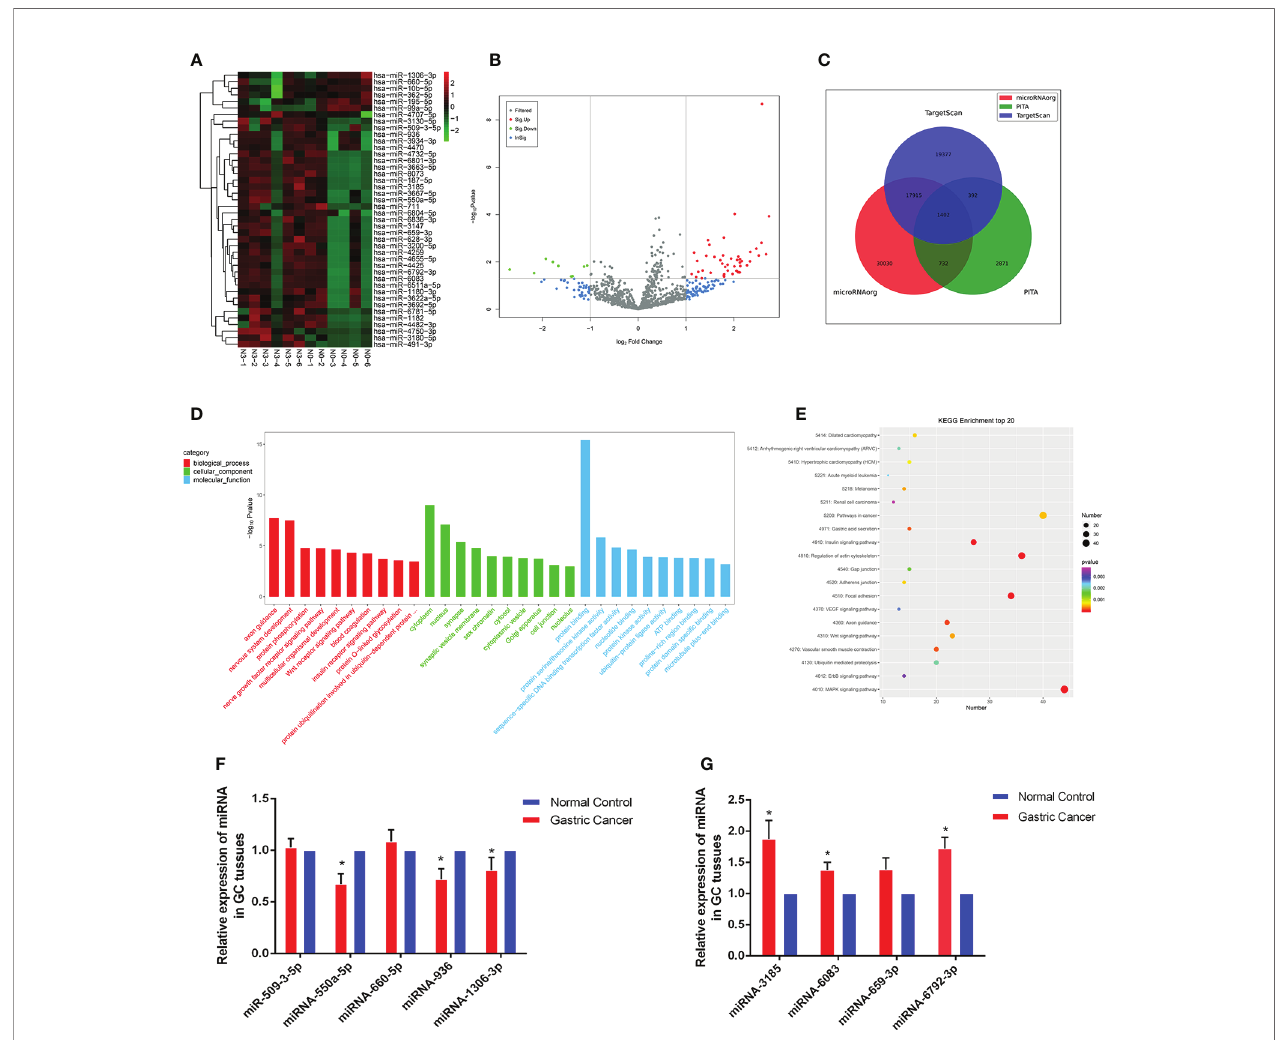
FIGURE 1 | Pro fi ling of miRNAs in the tissues from GC patients with N0 and N3 group and the expressions of miRNAs GC tissues. (A) Heat map shows the upregulated and down-regulated miRNAs in N0 vs N3 group. (N0 for no lymph node metastasis, and N3 for at least 7 lymph node metastasis). Each column represents the expression pro fi le of a tissue sample, and each row corresponds to a miRNA. High expression level is indicated by “ red ” and lower levels by “ blue ” . (B) Volcano plot shows tp-regulated and down-regulated circRNAs in cancer vs normal group. Higher expression levels are indicated by “ red ” , lower expression levels are indicated by “ green ” , and no signi fi cant difference is indicated by other colors. (C) TargetScan, PITA, microRNAorg database for target gene prediction of differential miRNAs. (D) GO analysis of miRNAs in N0 vs N3 group. (E) KEGG analysis of miRNAs in N0 vs N3 group. (F, G) Expression of nine miRNAs in GC tissues compared to normal controls. *P <